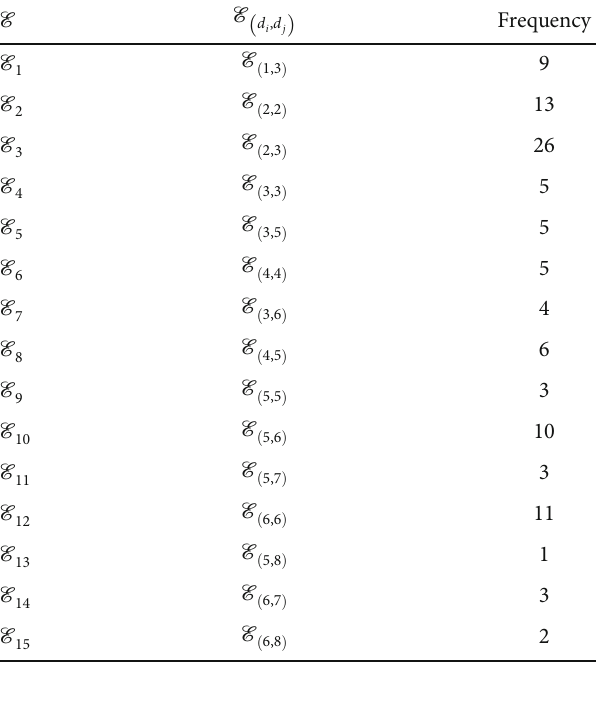
Table 5: Edge partitioning based on degree of ritonavir.